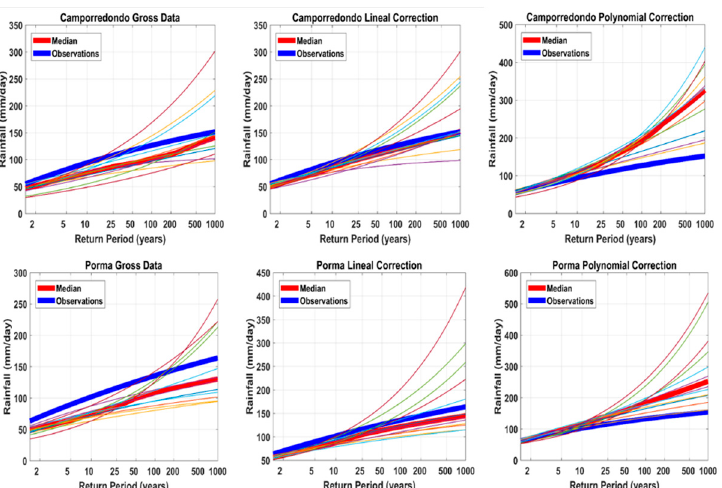
Figure 3. Frequency curves of annual maximum daily precipitation in two catchments (Camporredondo and Porma). Blue lines are observations. Red lines represent the median of the 12 climate models considered. The first column shows raw precipitation supplied by climate models. The second column shows linear bias correction. The third shows polynomial bias correction. Each row shows a case